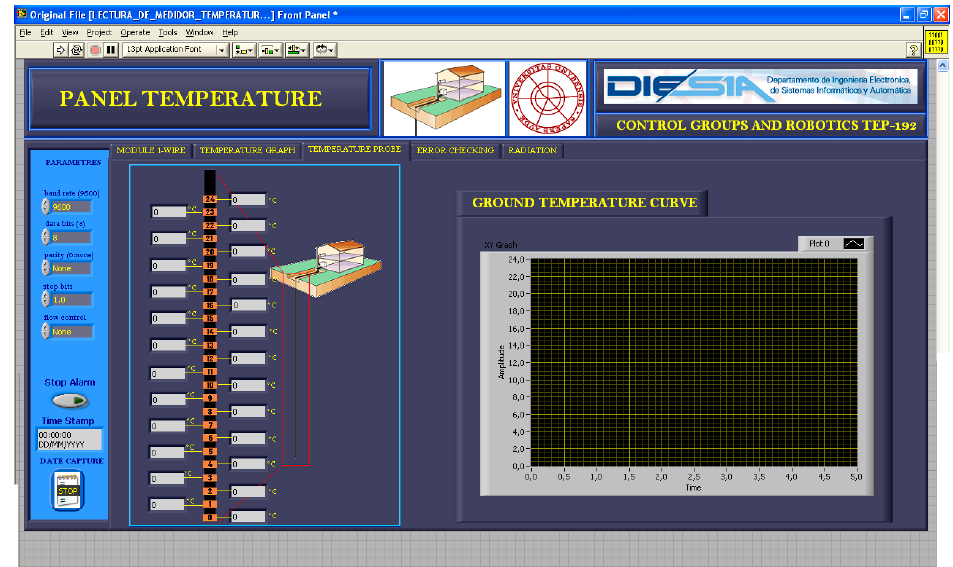
Figure 7. Real time temperature measurement of the 24 TS of the GTP.